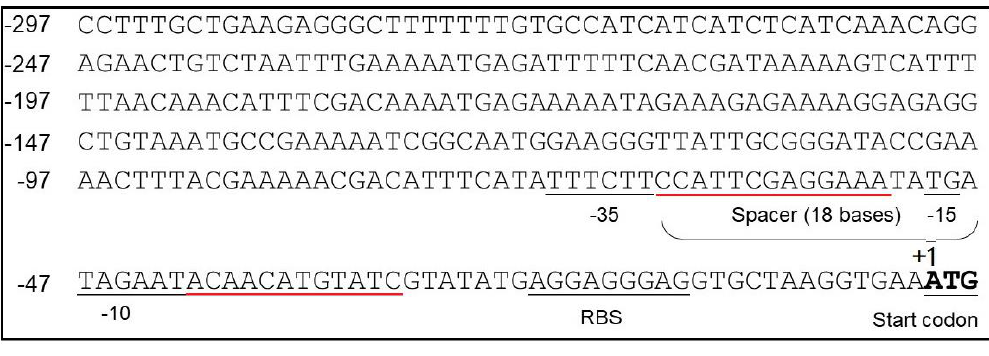
Figure 2. Sequence analysis of the P 2069 promoter. The predicted −35 and −10 boxes and the spacer sequences between these two elements were indicated; The start codon and ribosome binding site (RBS) were also labeled. The regions underlined in red were selected for mutagenesis in promoter engineering.